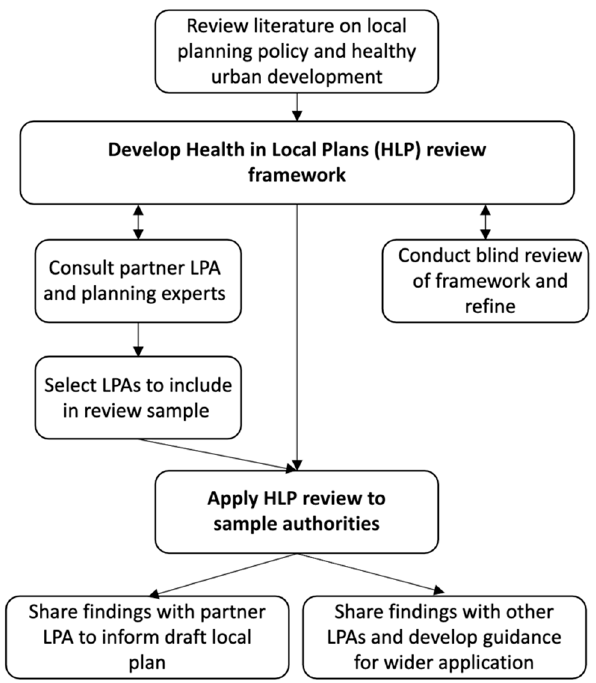
Figure 2. Steps to formulate the Health in Local Plans review